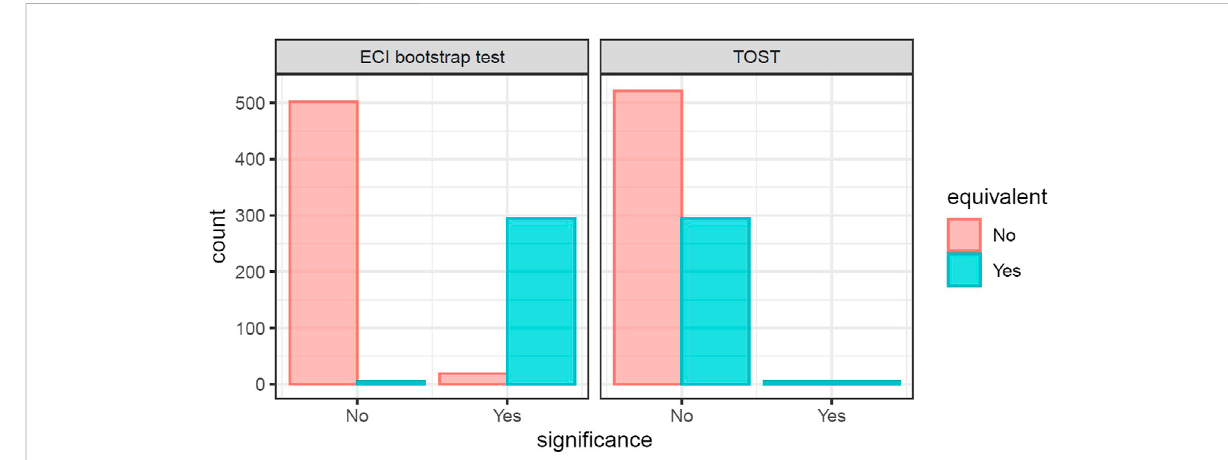
FIGURE 3 Example plots of decisions based on the q-value by the two tests of one simulation iteration. Left is the signi fi cance decision of the ECI bootstrap test, right is the signi fi cance decision of the TOST.